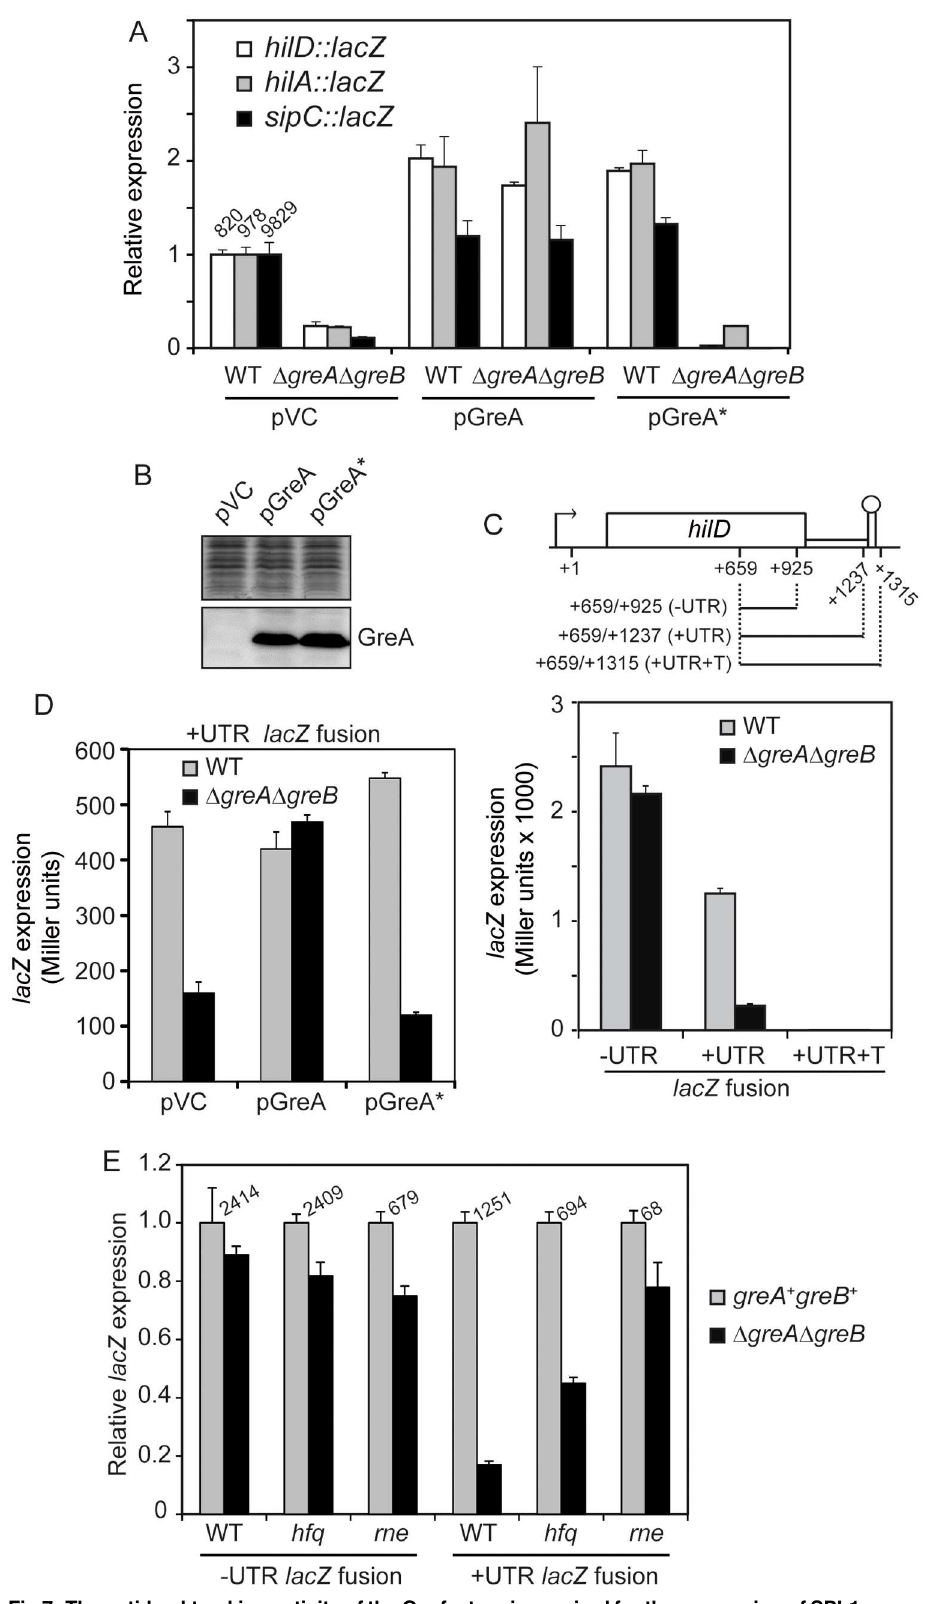
Fig 7. The anti-backtracking activity of the Gre factors is required for the expression of SPI-1 genes by alleviating a transcriptional pause located within the 3’-UTR of hilD . (A)